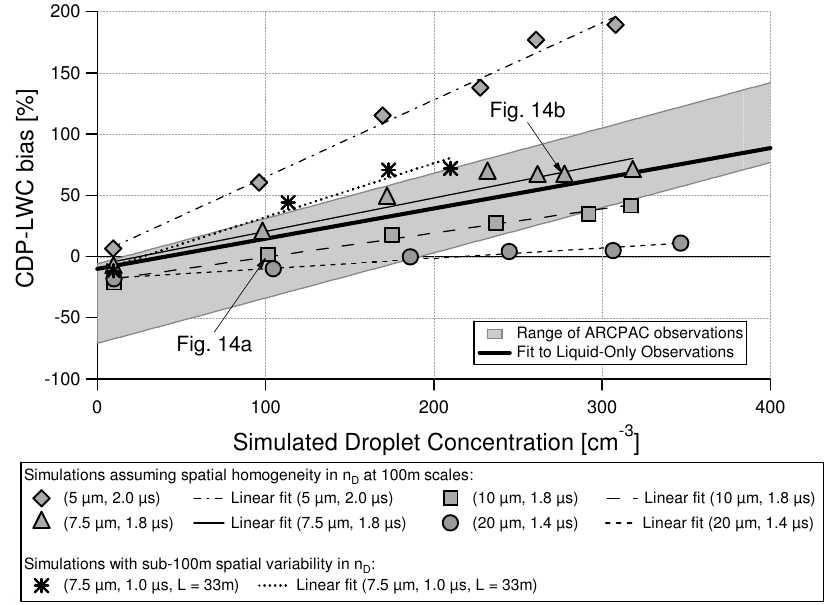
Fig. 15. Simulated bias in CDP-LWC as a result of coincidence errors, plotted as a function of simulated droplet concentrations. Plotted for comparison is the observed range (one standard deviation) in CDP-LWC bias versus droplet concentration for the mixed-phase clouds sampled during ARCPAC and the linear fit to the liquid-only clouds sampled on 29 March 2008. Compare to actual data in Fig.